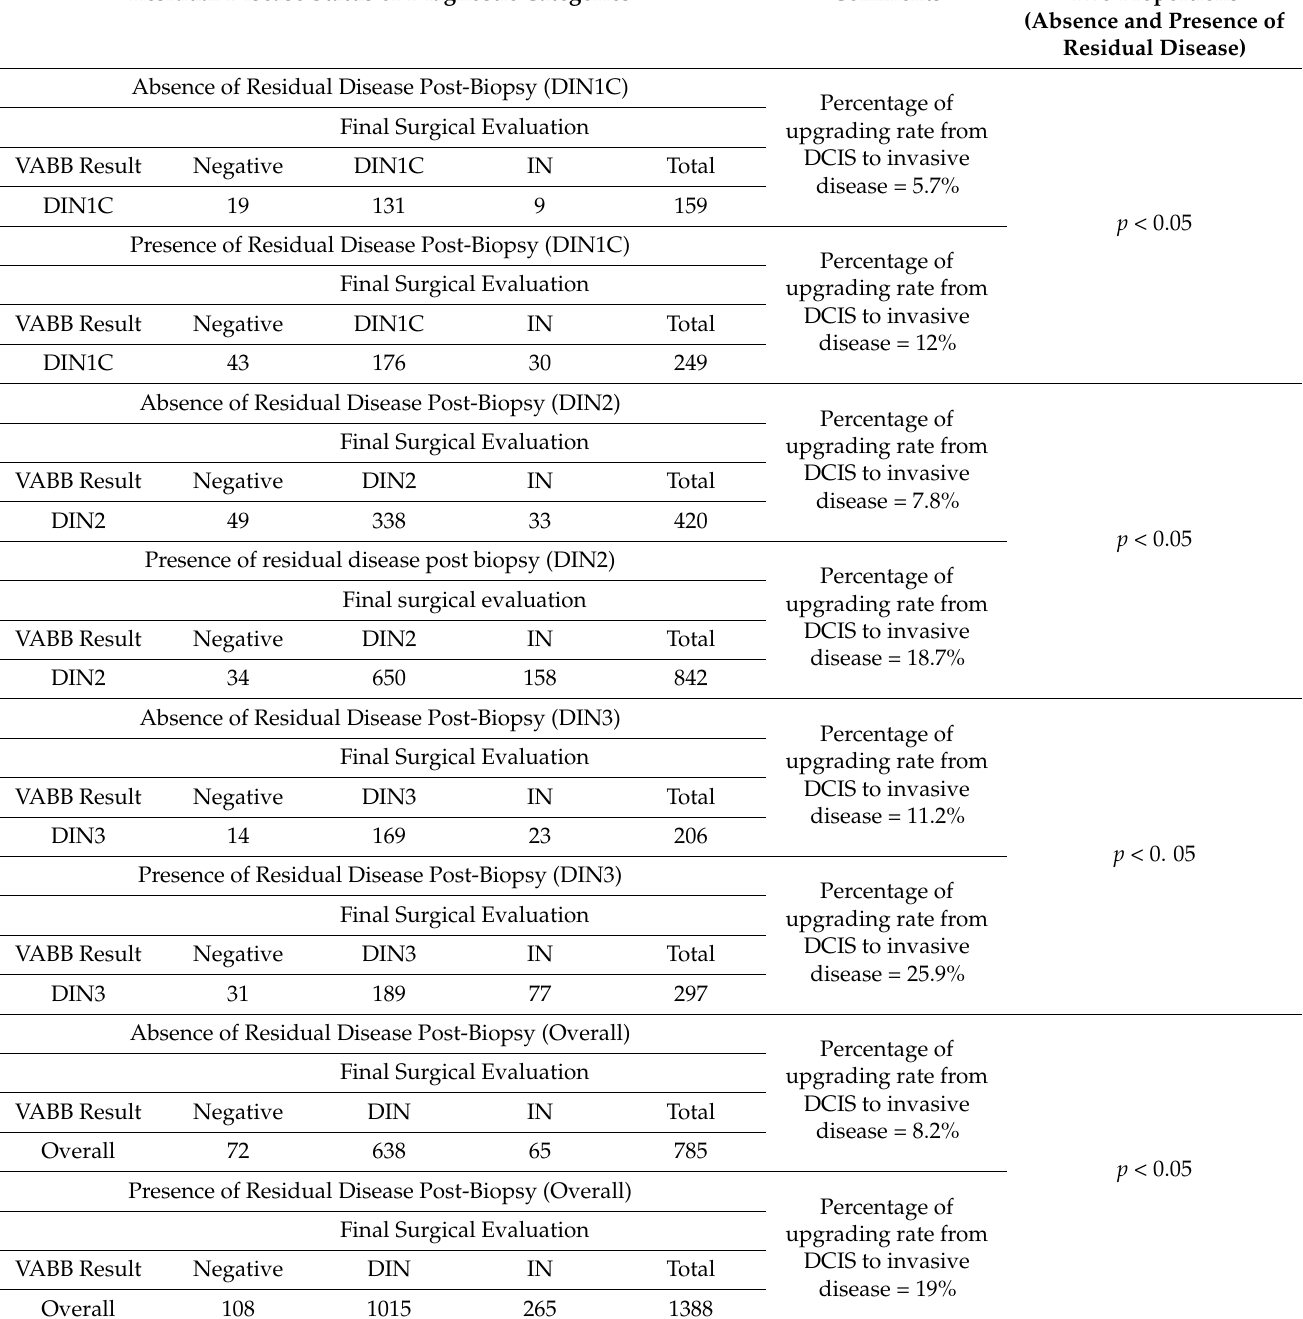
Residual Disease Status of Diagnostic